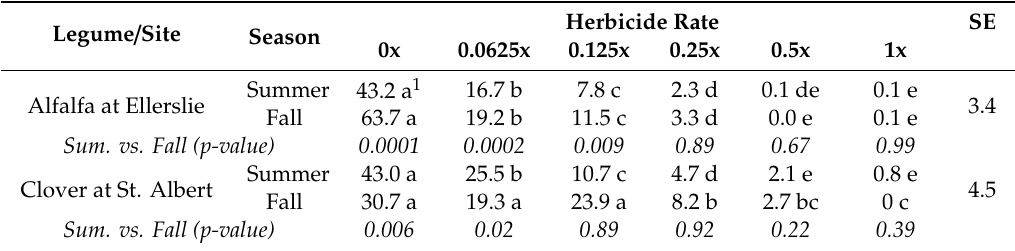
Figure 3. Mean ( ± 1 SEM) forage plant density for each of two legume species at each of two study locations, following spraying with broadleaf herbicide at six rates representing 0, 1, 2, 3, or 4 progressive half-lives of degradation, as well as a nontreated check. Data include: ( A ) alfalfa at St. Albert, ( B ) alfalfa at Ellerslie, ( C ) white clover at St. Albert, and ( D ) white clover at Ellerslie. Y-axes are scaled the same for comparison among legume species and locations. Di ff erent letters di ff er based on a Tukey HSD test ( p ≤ 0.05). Table 4. Mean densities of alfalfa and clover (plants m − 2 ) in response to varied herbicide application rates at either the Ellerslie or St. Albert study sites, in relation to di ff erent seasons of sampling. Results are combined across the AMCP and AMP treatments and over years (2010 and 2011). Rates emulate herbicide residues associated with sequential half-lives ranging from one (0.5 × check) to four (0.0625 ×